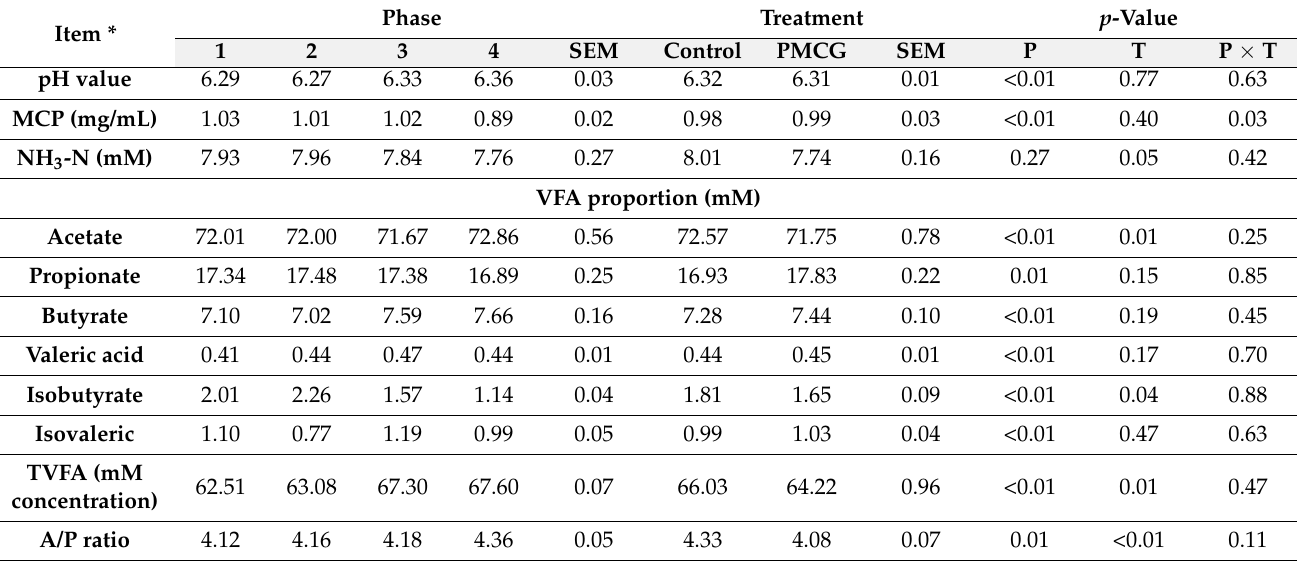
Table 4. Effects of PMCG on rumen fermentation properties of